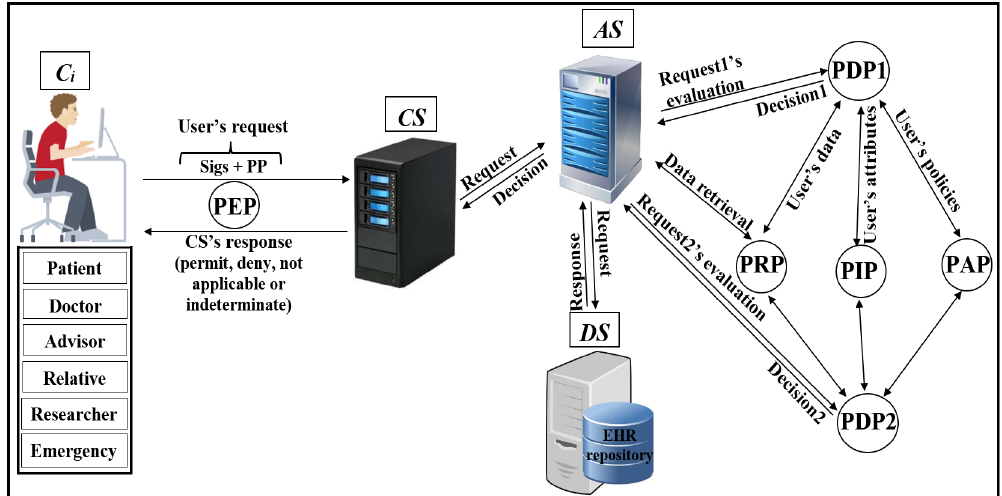
Figure 4. Pseudonymization and Anonymization with the XACML (PAX)